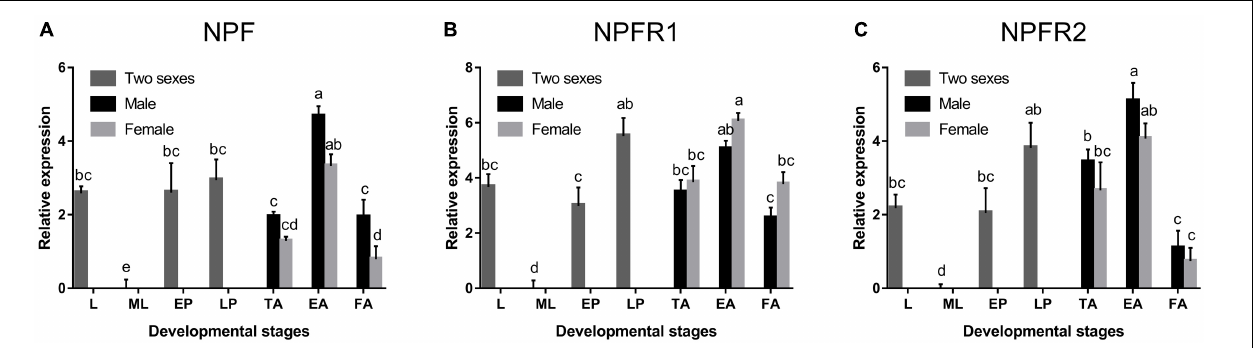
FIGURE 1 | Relative mRNA expression levels of NPF (A) , NPFR1 (B) , and NPFR2 (C) in different developmental stages of D. armandi . The relative expression levels were normalized with β -actin and CYP4G55 using the expression levels in the mature larvae for calibration. Different lowercase letters indicate significant differences at the 0.05 level. All values are mean ± SE , n = 3. L, larvae; ML, mature larvae; EP, early stage pupae; LP, late stage puage; TA, teneral adults; EA, emerged adults; FA, feeding adults.